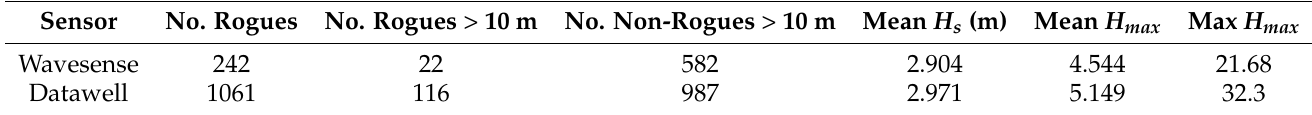
Table 5. Statistics from hourly data from both wave sensors. Data are available from both from 27 April 2020 to 6 May 2022, accounting for sensor outages, there are a total of 15,091 hourly reports